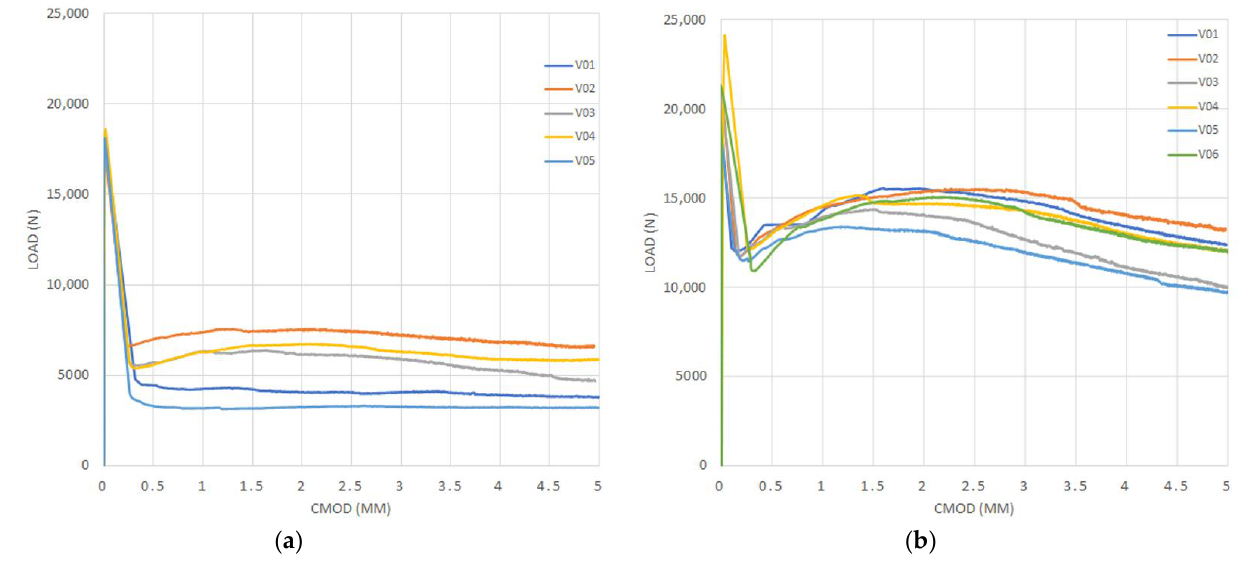
Figure 6. Curves of bending tensile test for the ratio (a/d) = 0.08: ( a ) Series 1 and ( b ) Series 2.